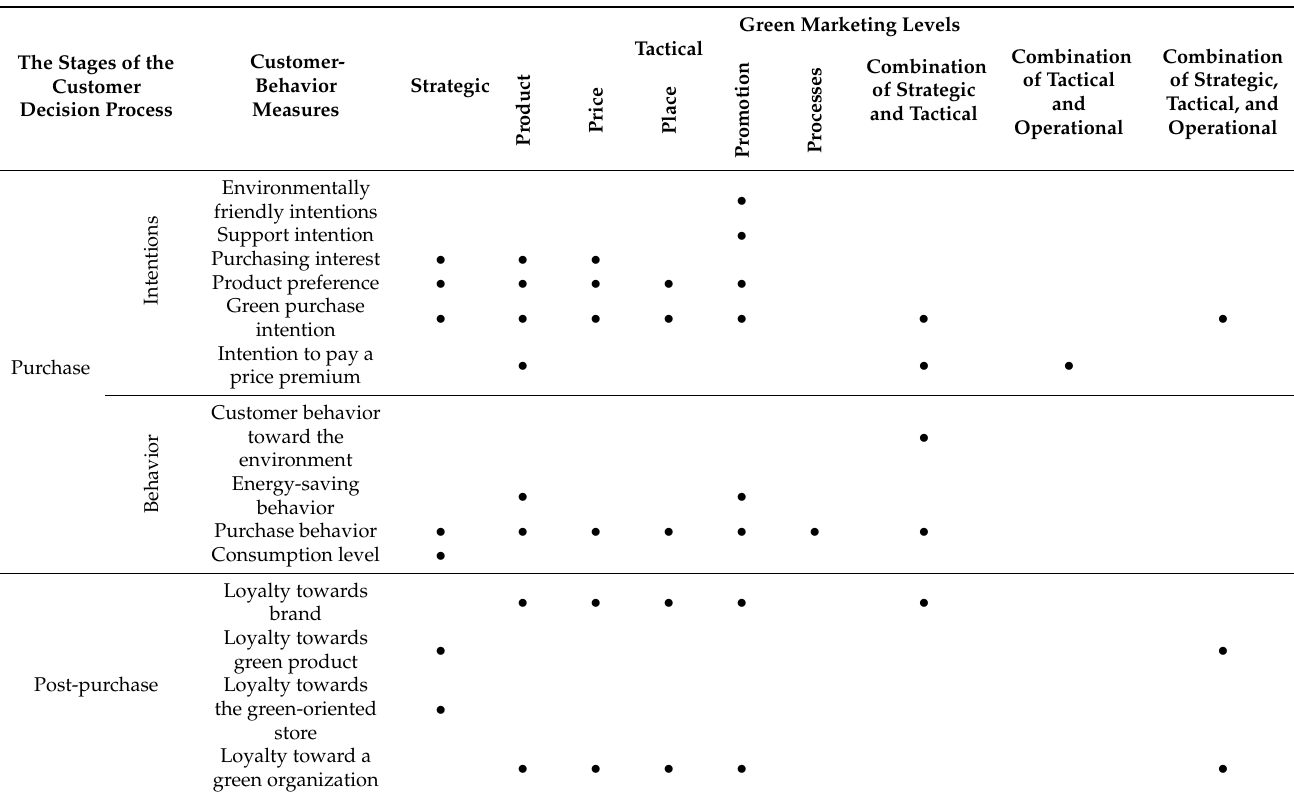
Table 6. The researched paths between green marketing at different levels and specific customer- behavior